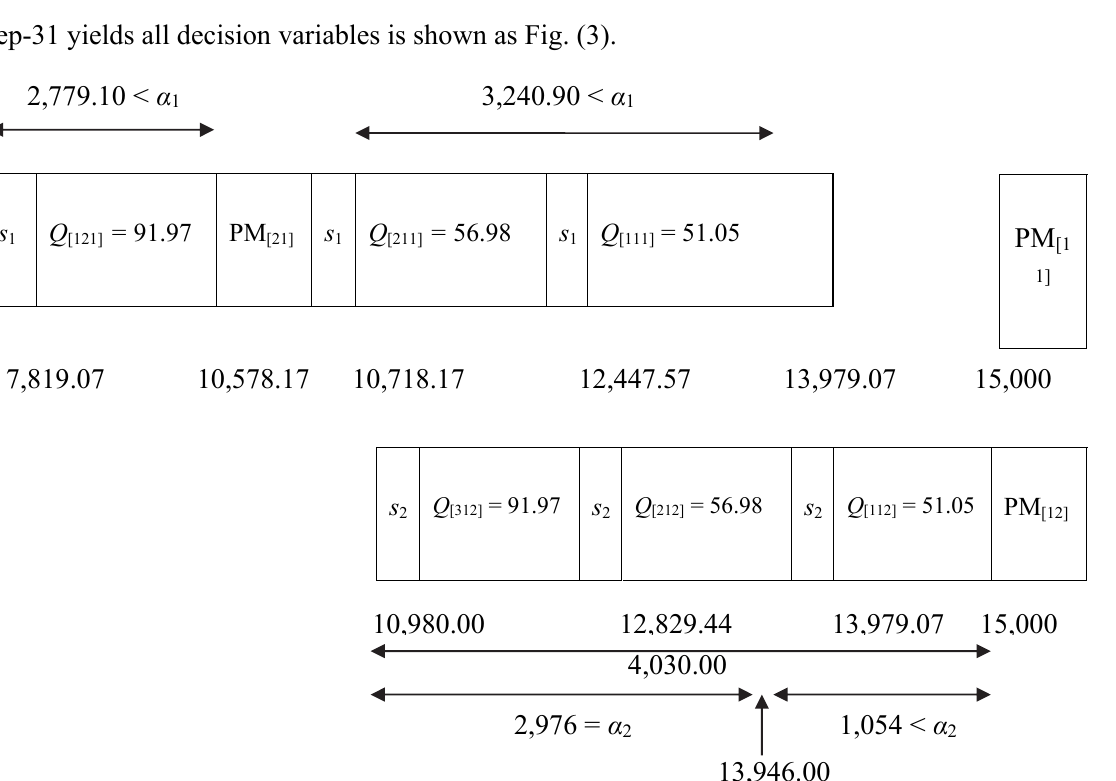
Fig. 3. Gantt-Chart for the best solution of Algorithm